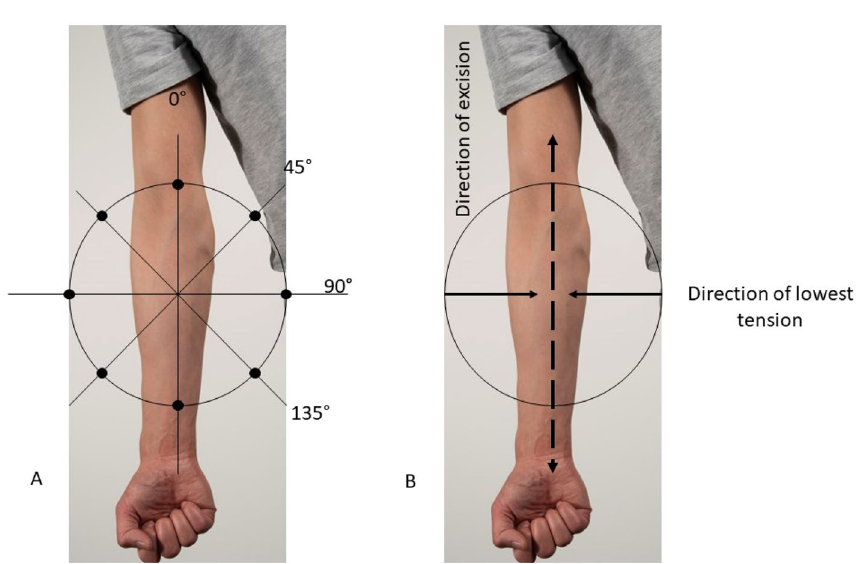
Figure 3. ( A ) The four angles measured: 0, 45, 90 and 135°. The 0 line represents the known Langer line from the literature. In theory, the 90° line should be the direction of lowest skin tension. ( B ) Example: if 90° is the lowest measured tension, the preferred excision line would be 90°